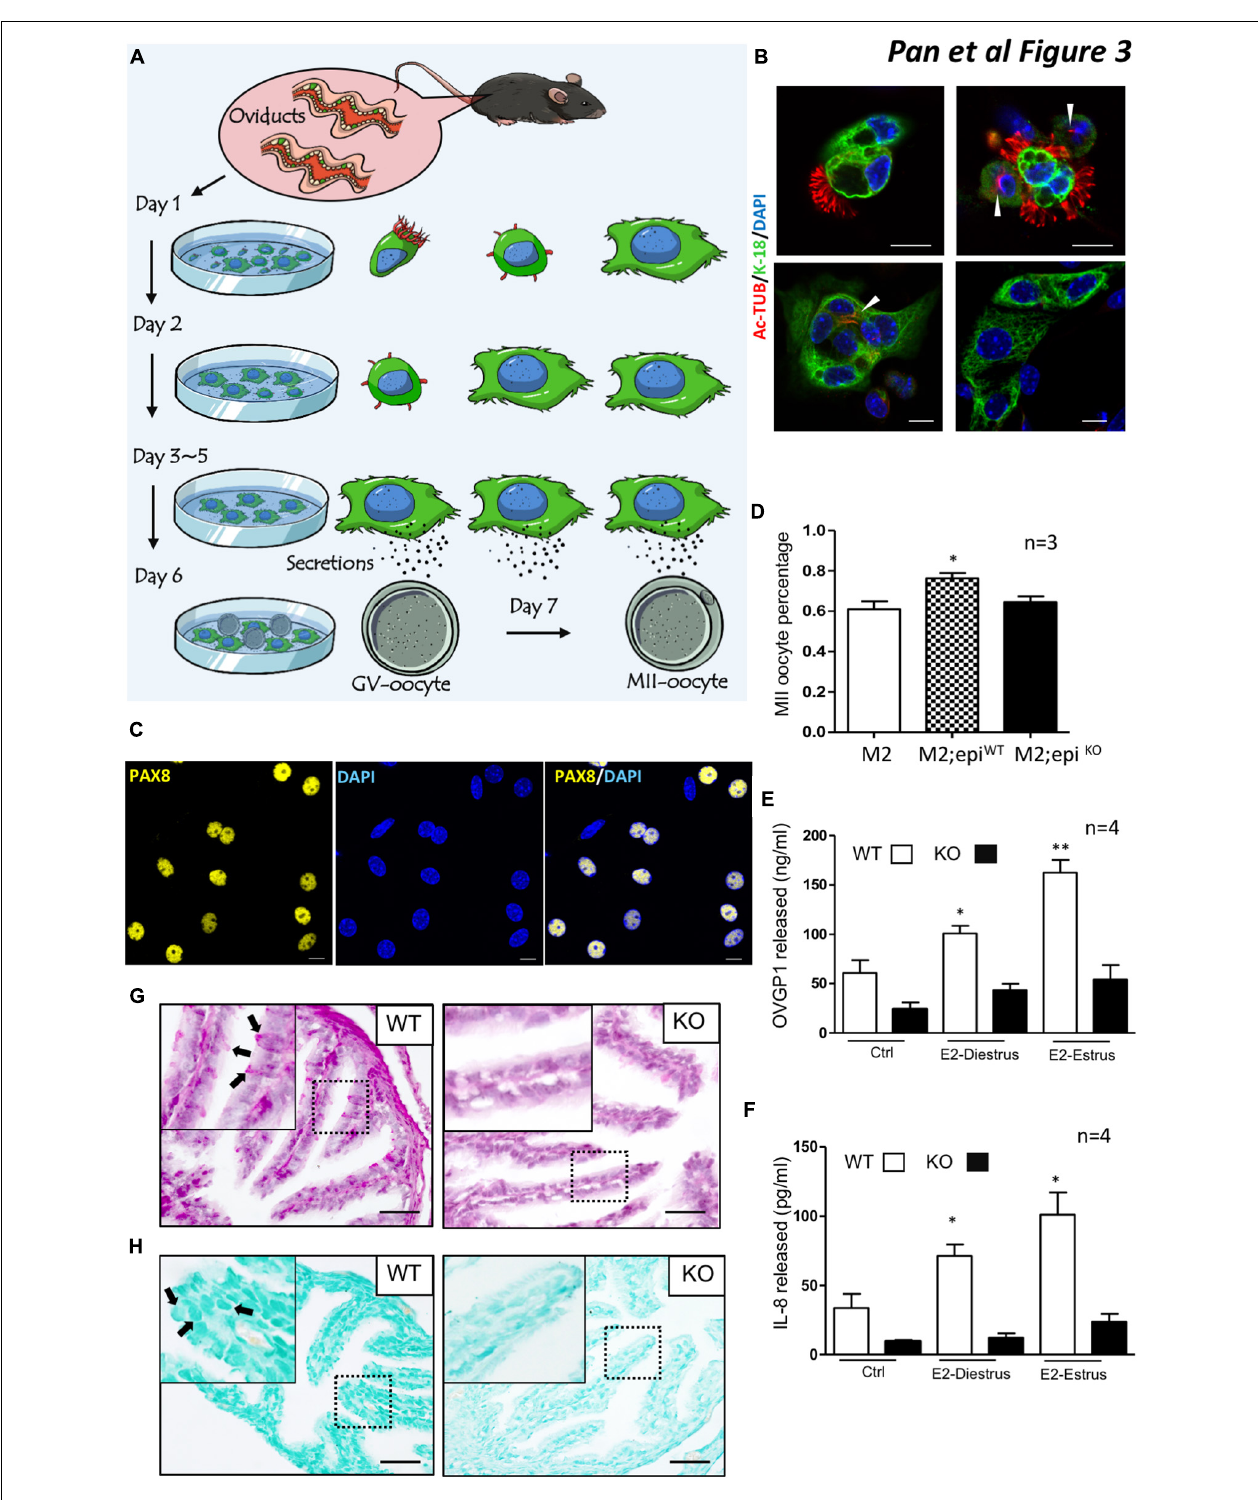
FIGURE 3 | Secretion deficiencies in the oviducts of Lgr4 KO mice. (A) A schematic showing the procedure for mouse oviduct epithelial cell–oocyte co-culture system. (B) Immunofluorescence analysis of cytokeratin 18 (KRT-18) and alpha-tubulin (Ac-Tub) to the mouse oviduct epithelial cells. (C) Immunofluorescence analysis of PAX8. (D) The average percentage of the MII oocytes in response to different treatments. (E) The released protein level of OVGP1. (F) The released protein level of IL-8. (G) The periodic acid–Schiff (PAS) staining between the WT and Lgr4 knockout oviduct. (H) The Alcian blue staining between the WT and Lgr4 knockout oviduct. ∗ p ≤ 0.05; ∗∗ p ≤ 0.01. Scale bar, 10 µ m in (B,C) , 25 µ m in (G,H) . At least three independent experiments were carried out.